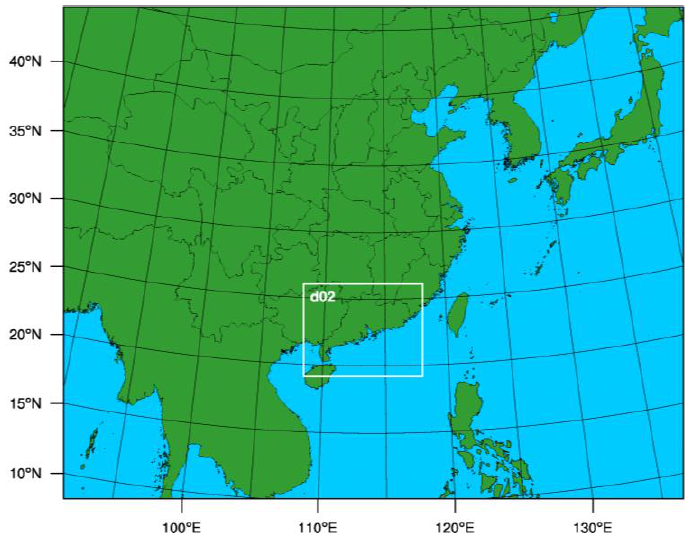
Figure 2. The WRF-Chem model domain setting and